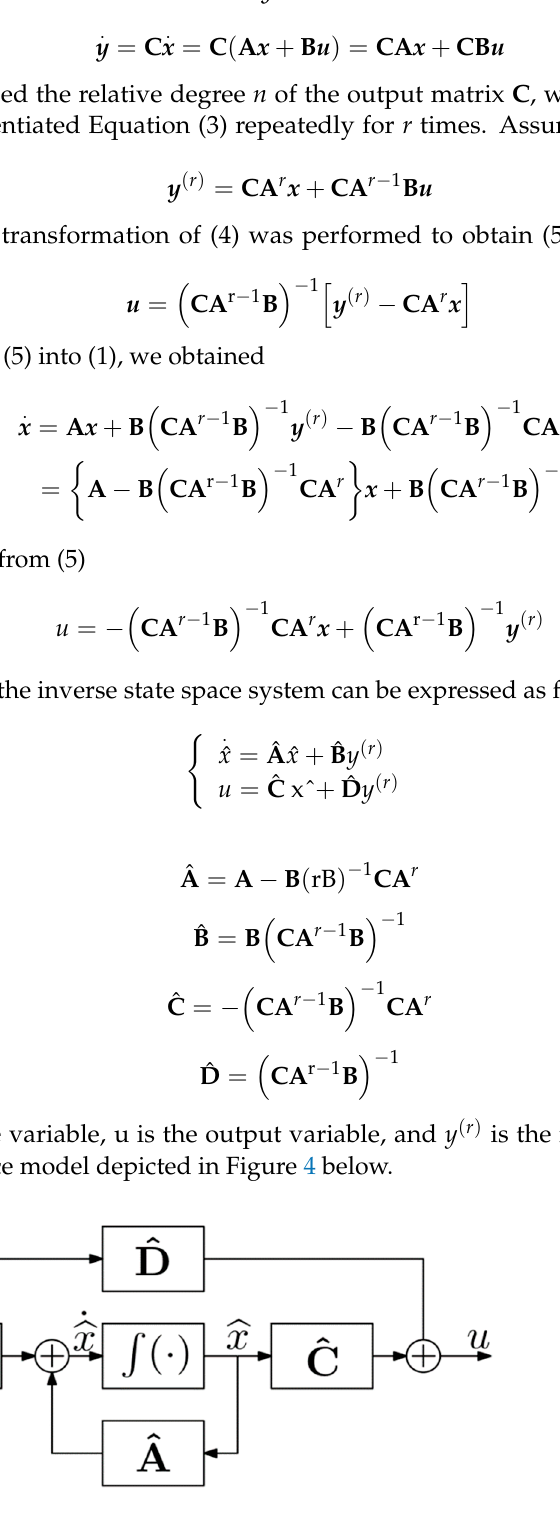
Figure 4. State space representation of the inverse system.